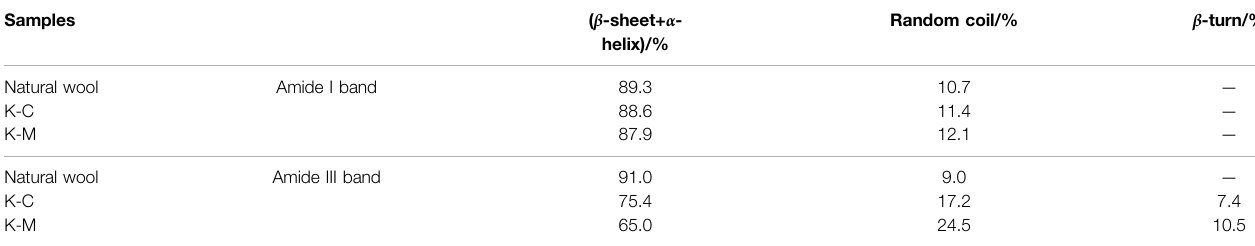
TABLE 2 | The integral area ratio of the characteristic absorption peaks of the amide I and III band in IR spectra of samples. Samples ( β -sheet+ α -